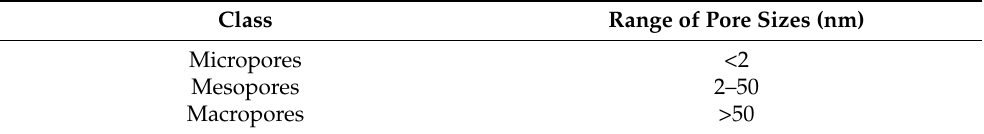
Table 6. IUPAC pore size